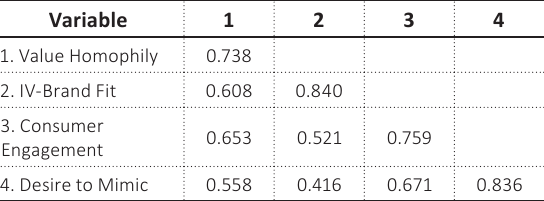
Table 2. Discriminant validity